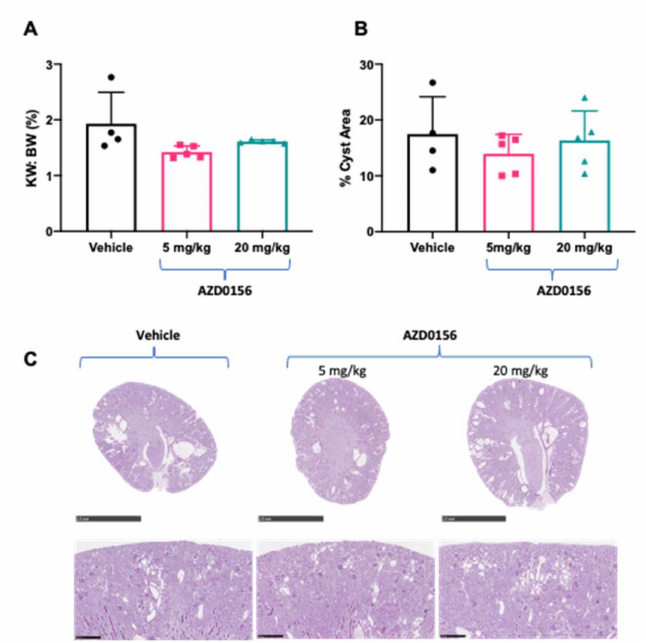
Figure 5. Effects of AZD0156 (5 or 20 mg/kg/day) via oral gavage for 10 days on body weight, kidney enlargement and cyst area in Pkd1 RC/RC mice. ( A ) Mean kidney weight to body weight ratio (KW: BW) in the experimental groups. ( B ) Mean percentage cyst area in experimental groups. ( C ) Representative whole-slide digital images of Periodic Acid Schiff (PAS)-stained kidney sections from mice in the experimental groups. Scale bars in top panel indicates 2.5 mm and bottom panel 0.25 mm. Data presented as means ± SD ( n = 4–5 per